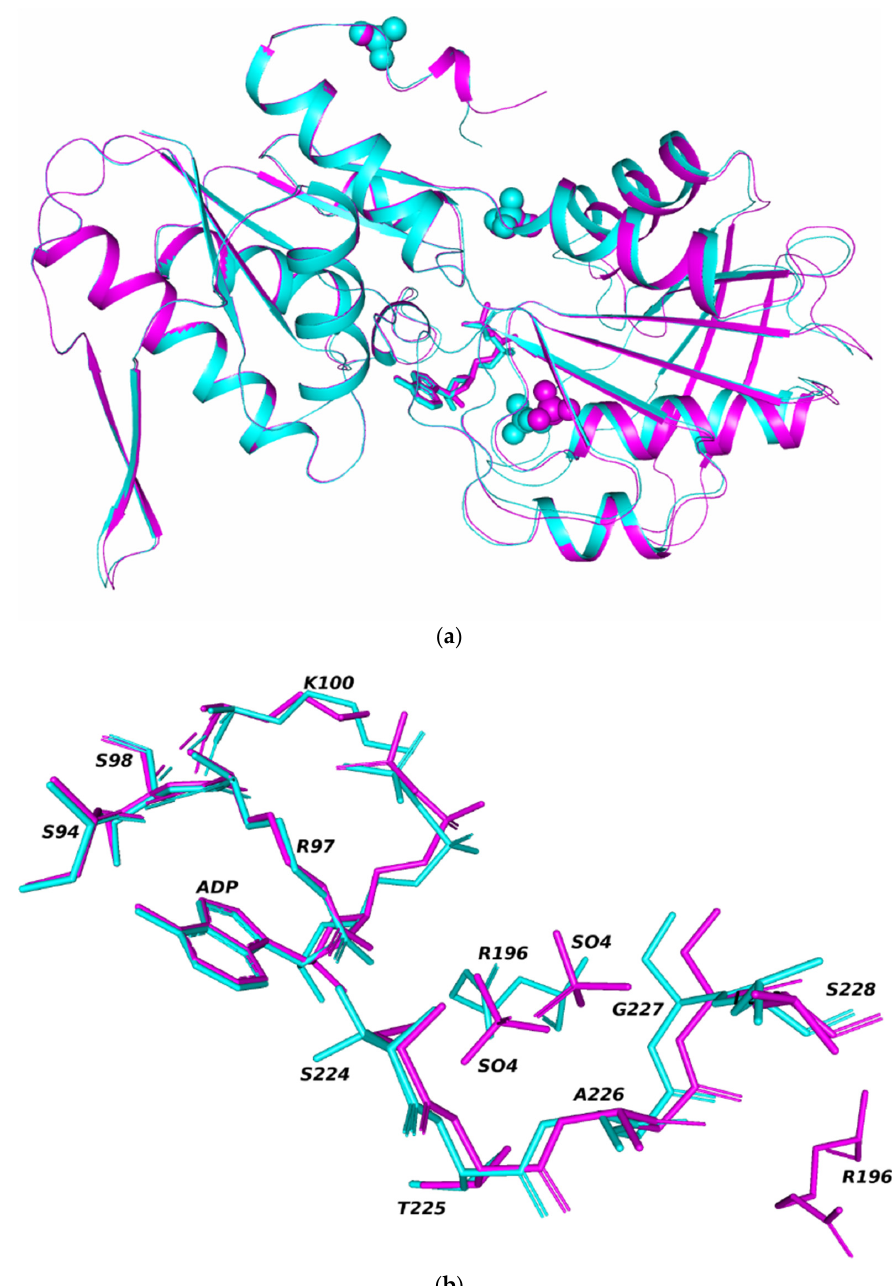
Figure 2. Superposition of two independent subunits A and B of the Tth2PRPPS HB27 molecule in rhombohedral crystals. The spheres show sulfate ions. The sticks show the ADP molecule: ( a ) sulfate ions and ADP molecules in the active centers of superimposed subunits A and B ( b ). When subunits with a closed conformation of the active center from different crystal modifications (subunits B with closed conformation in rhombohedral crystals and subunit B with closed conformation in tetragonal crystals) were superimposed over 255 C α atoms, the average rmsd was 0.369 Å (Figure